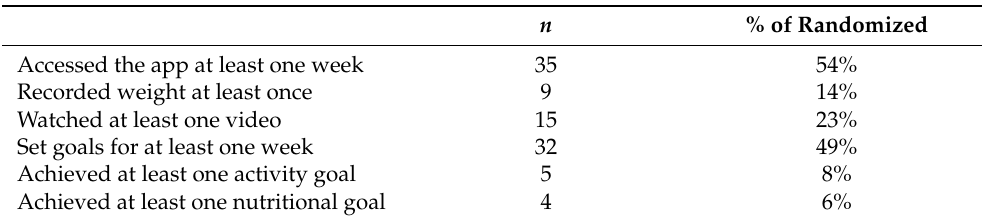
Table 2. Engagement metrics downloaded from the BeFAB